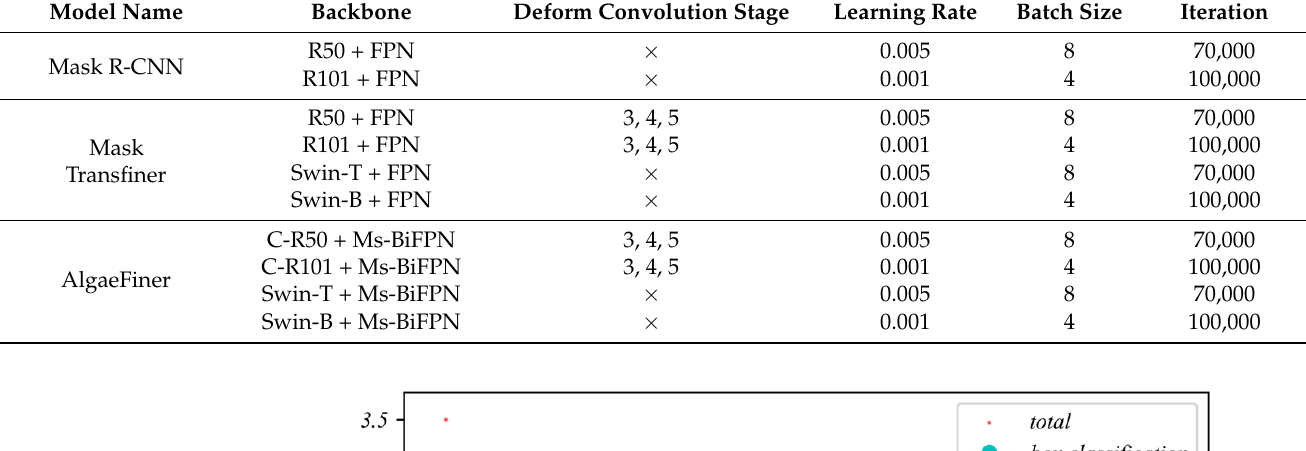
Table 3. Model configurations and training hyper-parameters.